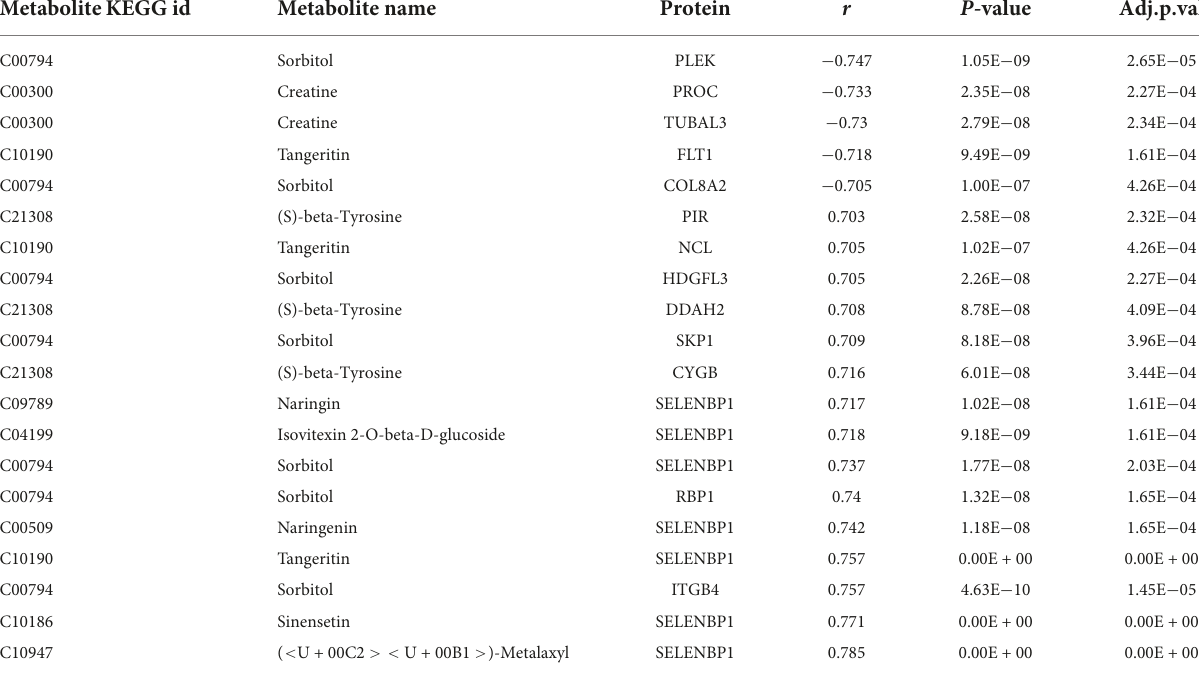
TABLE 2 Co-expression of differential metabolites and differential proteins with absolute value of Spearman correlation coefficient more than